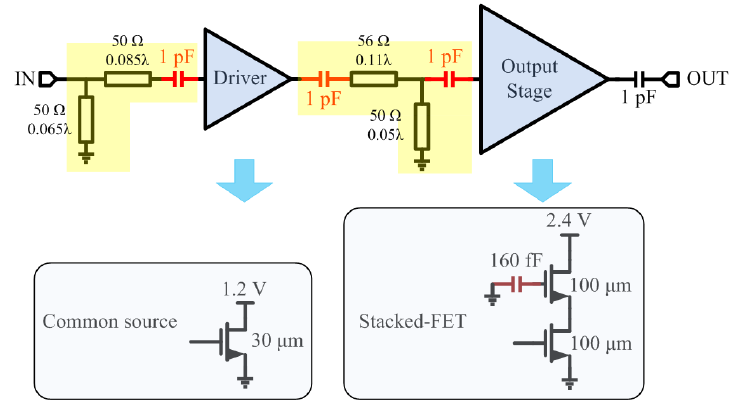
Figure 5. Schematic of the proposed PA. Series-connected DC-blocking capacitors are utilized in the CPW matching networks.